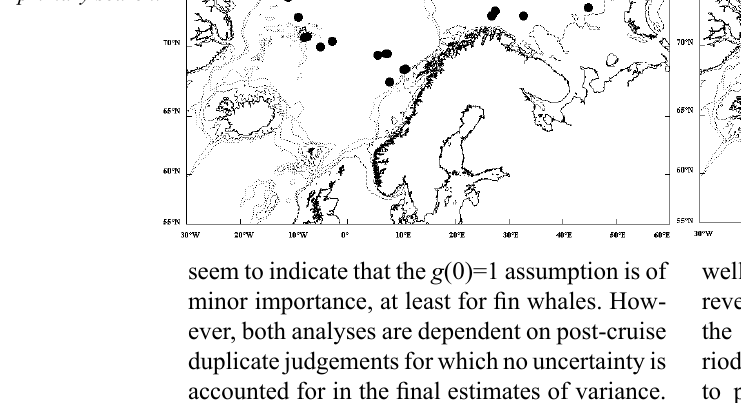
Fig. 2. Distributions of sightings re- corded as fin whales during the 1995 (a) and 1996-2001 (b) surveys from the up - per platform during primary search.